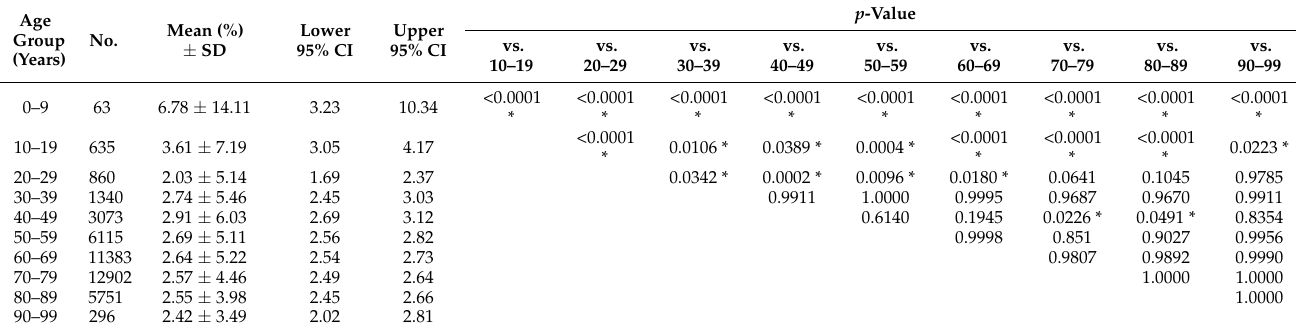
Table 5. Comparison of FPs among age-stratified